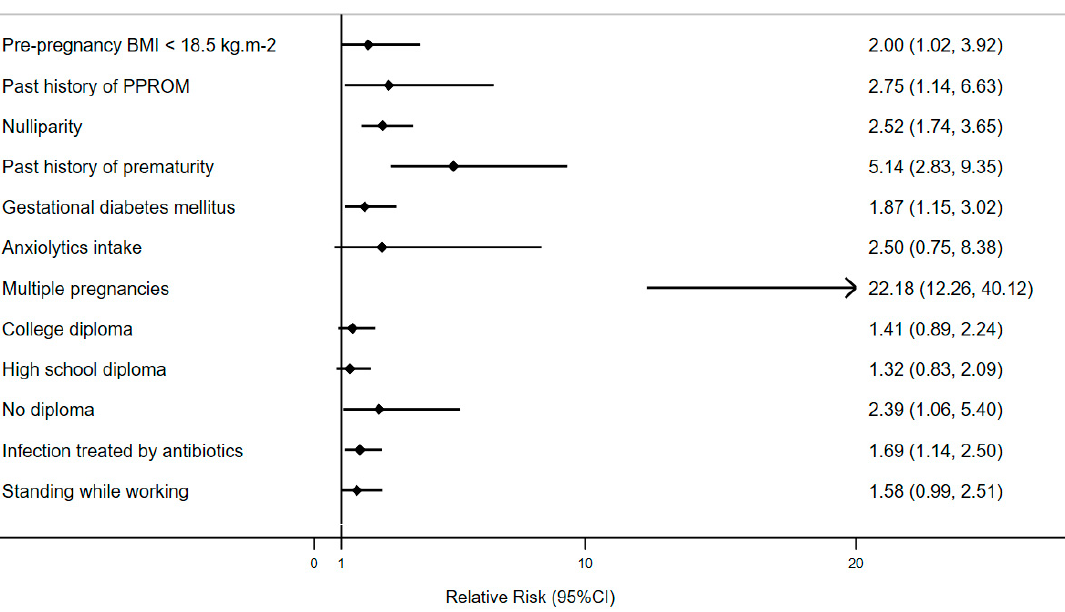
Figure 2. Forest plot showing odds ratios for risk factors of preterm premature rupture of membranes integrated into a multivariable analysis after a bootstrapping process. Horizontal lines represent 95% CIs. CI: confidence interval.